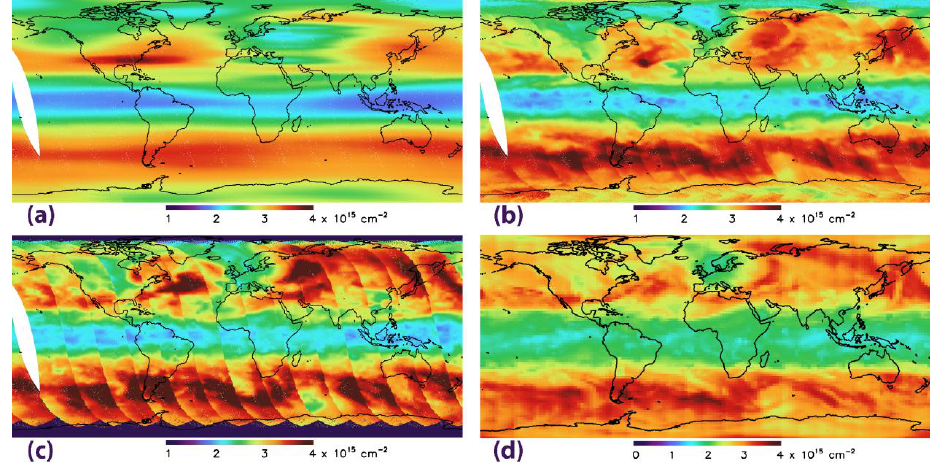
Fig. 7. Stratospheric NO 2 vertical-column retrieval for the date 21 March 2005. (a) SP1. (b) SP2. (c) DOMINO. (d) GMI (scaled to the Figure 7 : Stratospheric NO 2 vertical column retrieval for the date 21 March 2005. (a) SP1. 3 magnitude of SP2 using latitude-dependent scaling factors). (b) SP2. (c) DOMINO. (d) GMI (scaled to the magnitude of SP2 using latitude-dependent 4 scaling factors). 5